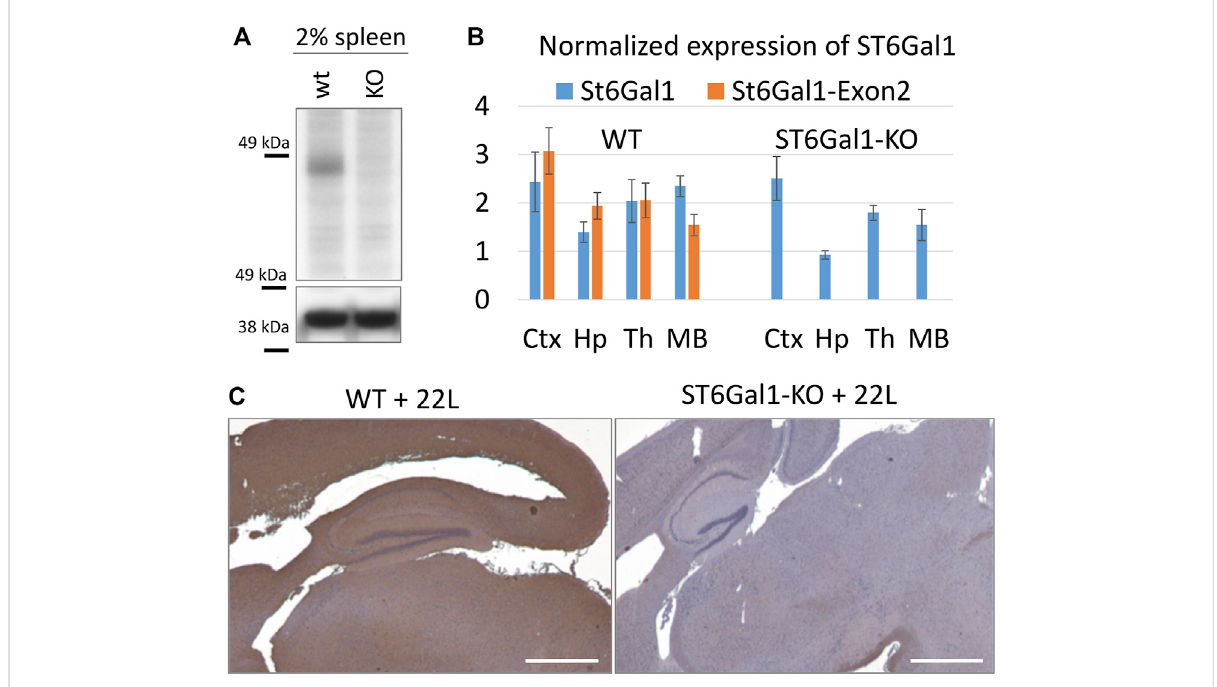
FIGURE 1 The global knockout of ST6Gal1. (A) Western blot of 2% spleen tissues from ST6Gal1-KO (KO)and control C57Bl/6 (WT) mice stained with anti- ST6Gal1 antibody (#AF5924, R&D Systems, Minneapolis, MN). (B) RT-qPCR analysis of ST6Gal1 expression using Bio-Rad primers (qMmuCID0009827)orprimerstoExon2ofthegeneincortex(Ctx),hippocampus(Hp),thalamus(Th)andmidbrain(MB)fromST6Gal1-KO(KO)and control C57Bl/6 (WT) mice. Each sample was analyzed in triplicate. The mean and standard deviation are shown. TBP was used as a housekeepinggene. (C) Stainingof22L-infectedbrainsofST6Gal1-KO(KO)andC57Bl/6(WT)mice,euthanizedat146and145dayspost-inoculation (dpi), respectively, using Sambucus Nigra lectin (SNA). Scale bar = 1